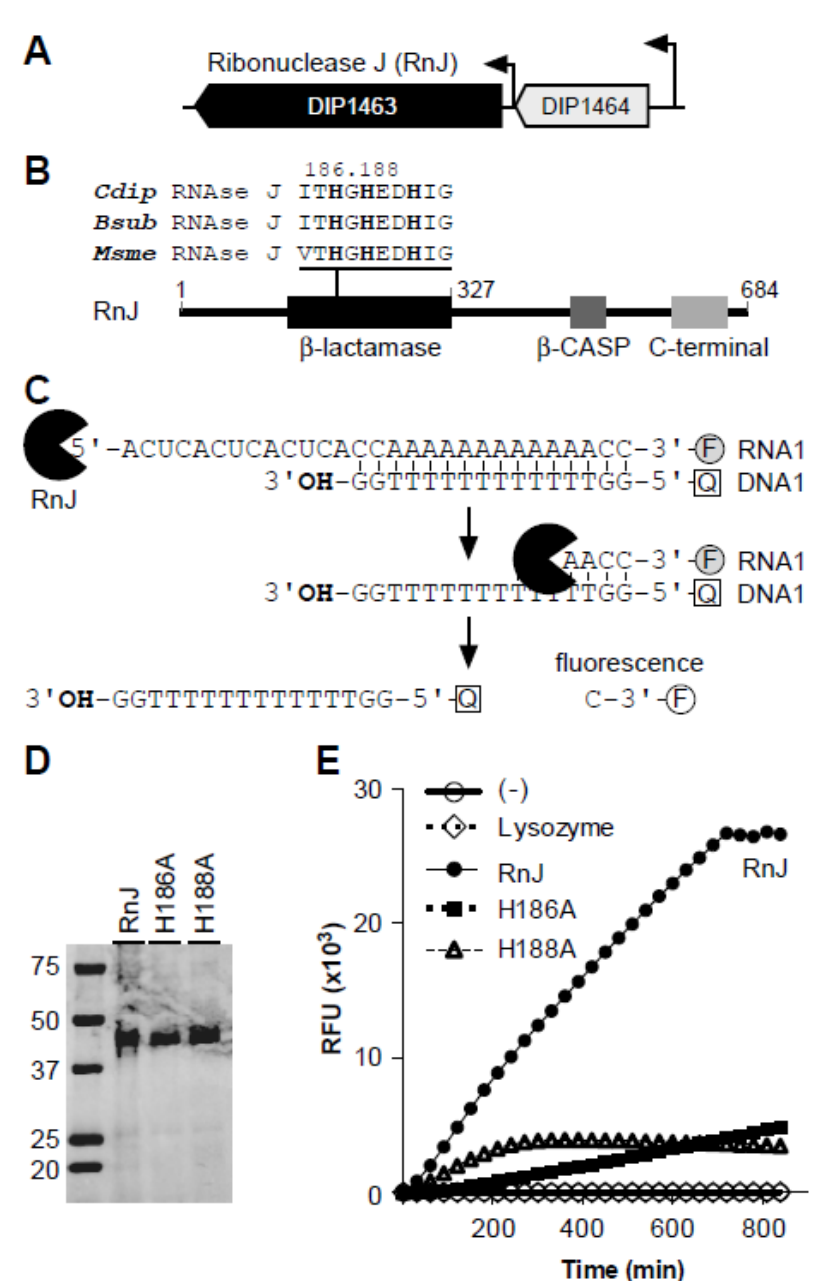
Figure 1. Corynebacterium diphtheriae encodes ribonuclease J (RnJ). ( A ) Presented is a diagram of a two-gene locus, in which DIP1463 is predicted to encode ribonuclease J (RnJ). The rnj gene is equipped with its own promoter but it is also part of a transcription unit with DIP1464. ( B ) RnJ harbors three domains—β-lactamase, β-CASP, and C-terminal. The β-lactamase region contains catalytic histidine residues in the motif II, which is highly conserved with other ribonuclease J proteins, including Bacillus subtilis (Bsub) and Mycobacterium smegmatis (Msme); numbers indicate the amino acid positions. ( C ) An RNA/DNA duplex, containing an RNA molecule with a fluorophore (F) at the 3′ (RNA1) and a DNA molecule with a quencher (Q) at the 5′ (DNA1), was used in a real-time fluorescence assay (RT-FeDEx) to probe exoribonuclease activity. Cleavage of RNA1 by DIP1463/RnJ permits fluorescence emission from the released fluorophore; adapted from [41]. ( D ) Purified RnJ recombinant proteins (wild-type and His mutants) were analyzed by SDS-PAGE and stained by Coomassie Blue; molecular mass markers are shown. ( E ) Five hundred nM of the RNA1/DNA1 duplex was mixed with 100 nM of recombinant RnJ proteins. Fluorescence signal was monitored over time. The data are representative of two independent experiments performed in triplicate. Lysozyme and a reaction without RnJ were used as controls.